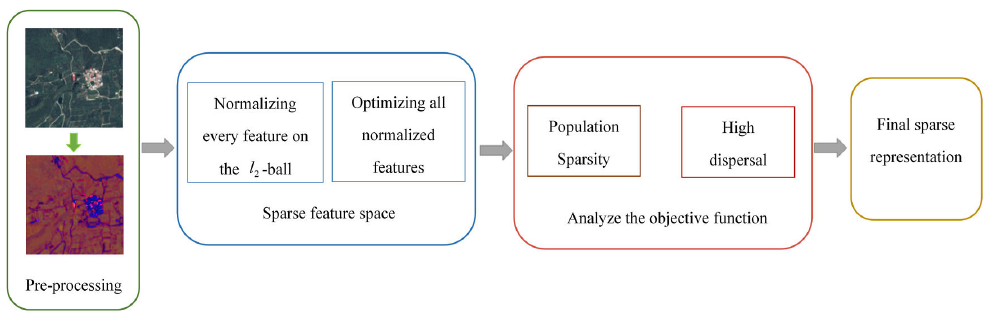
Figure 3. The structure of Hyperparameter Sparse Representation